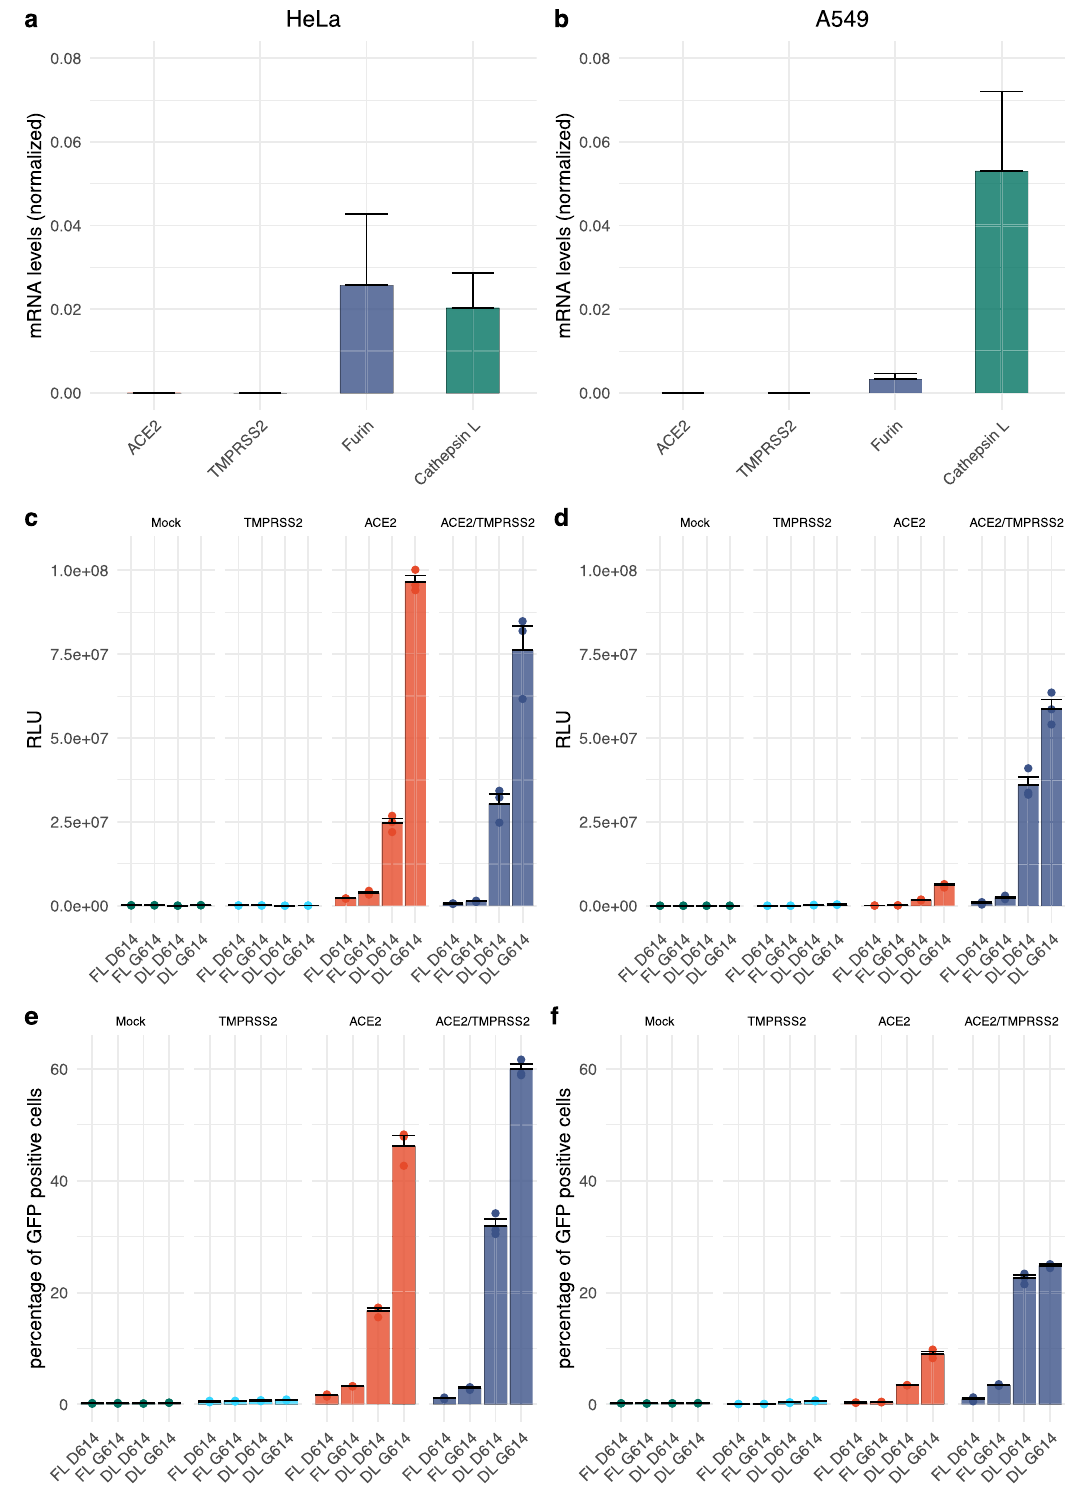
Figure 2. SARS-CoV-2 S-protein D614G variant shows increased infectivity. ( a , b ) Real-time RT-PCR for ACE2, TMPRSS2, furin and cathepsin L mRNA expression profiles in HeLa ( a ) and A549 ( b ) cells. ( c – f ) Spike pseudotyped lentiviral infectivity assays. Pseudotyped lentiviruses expressing Luciferase and GFP and pseudotyped with SARS- CoV-2-D614 or G614 full length or truncated version were used to transduce HeLa and A549 overexpressing or not either ACE2 and/or TMPRSS2. ( c , d ) Luciferase assay of HeLa ( c ) and A549 ( d ) at 5 days post transduction with 80 μL of SARS-CoV-2 spike pseudotyped lentivirus. ( e , f ) Percent of GFP + assay of HeLa ( e ) and A549 ( f ) cells at 5 days post transduction with 80 μL of SARS-CoV-2 S-protein pseudotyped lentivirus analysed by Flow cytometry. The experiments were done in triplicates and repeated three times with three independent lentiviral stocks that was resulting from independent transfection. One representative is shown with error bars indicating SEM of